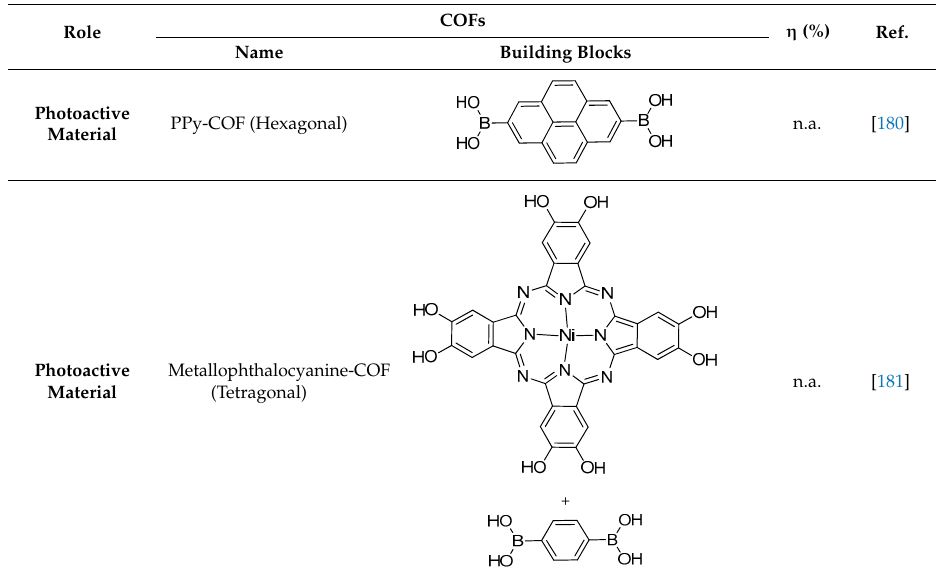
Table 4. COFs e ff ectively employed in DSSC. The reported values of photoconversion e ffi ciency could not be compared between each-others, yet they could shine light on the potentiality of this class of material.